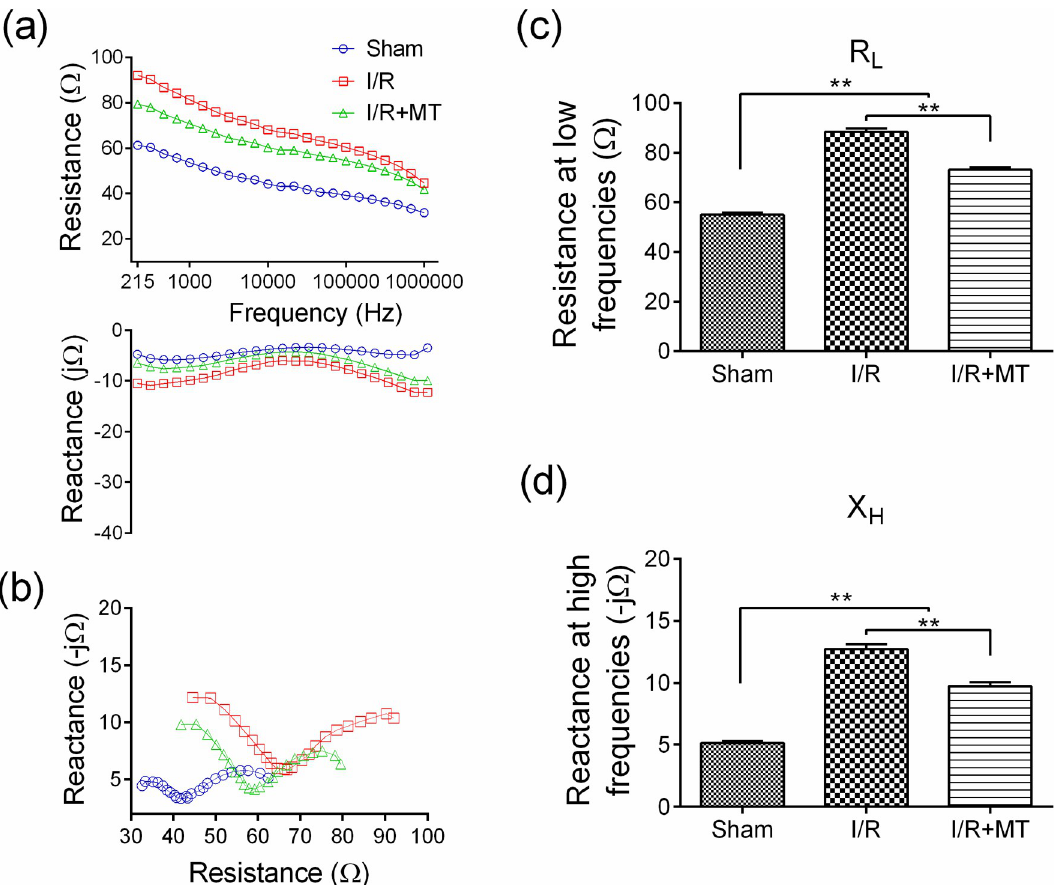
Fig 1. Effect of MT on the gastric mucosa impedance in experimental groups. (a) Graphic representation of the gastric impedance spectra (Resistance and Reactance) of the experimental groups: Sham, I/R and I/R+MT. (b) Cole-Cole plot (Resistance vs Reactance). Graphic representation of impedance parameters of the experimental groups: (c) Resistance at Low frequencies (R L ) and (d) Reactance at High frequencies (X H ). An ANOVA statistical test was performed followed by a Tukey post hoc test. The results are presented as the mean ± SEM. �� p < 0.001. Treatment with MT reduces measurements of gastric impedance parameters after the I/R model.